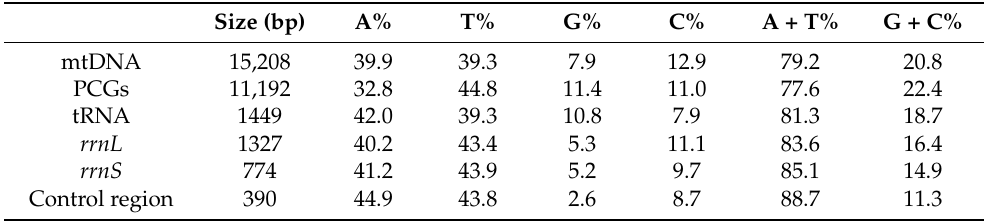
Table 4. Base composition of Hestinalis nama mitogenome.